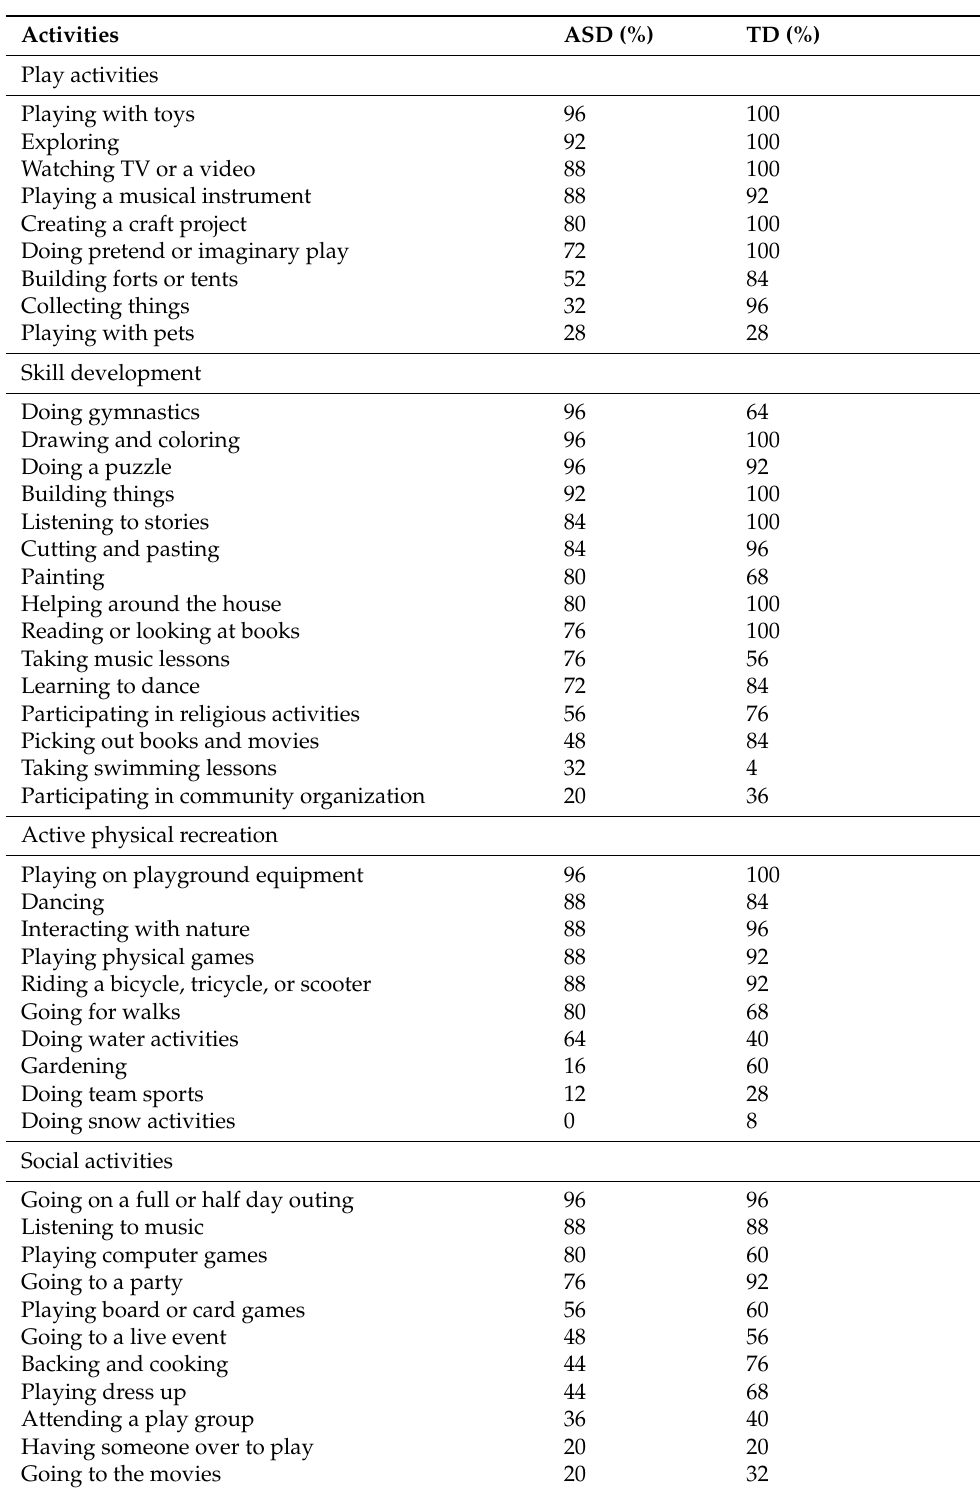
Table 2. Comparison of Percentage of Children Who Experienced Each Activity between Children with ASD and